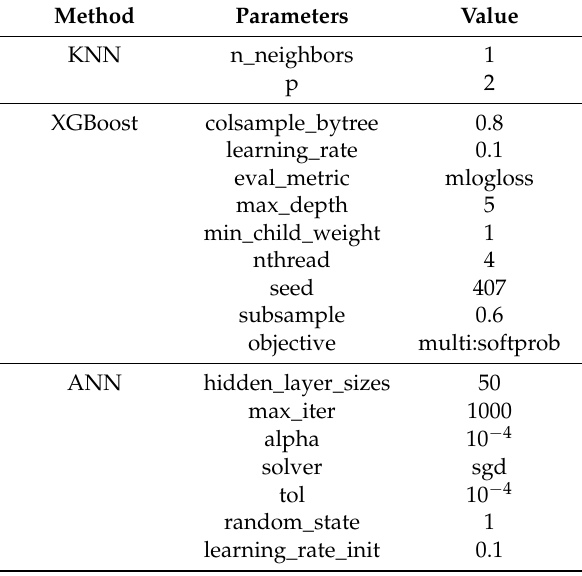
Table 2. Parameters in K nearest neighbors (KNN), artificial neural network (ANN), and extreme gradient boosting